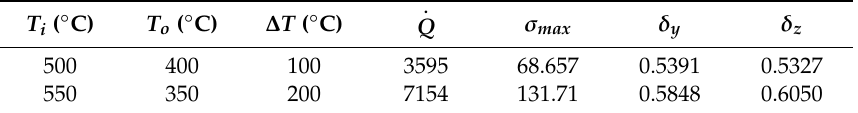
. m = 1 kg / s, H = 62 mm, d = 8 mm, φ = 0.53, m = Table 10. E ff ects of ∆ T for HP : h o = 250 W / (m 2 K), Table 10. Effects of Δ T for HP : h o = 250 W/(m 2 K), m  = 1 kg/s, H = 62 mm, d = 8 mm, ϕ = 0.53, m = 2.